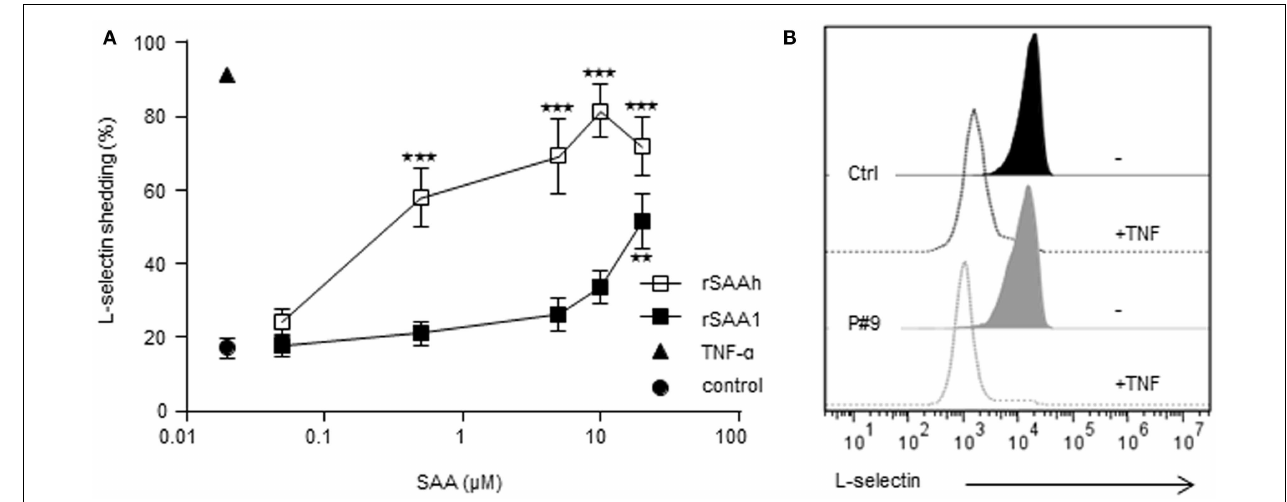
test where the SAA-treated samples were compared to the unstimulated control ( (cid:63)(cid:63) p < 0.01; (cid:63)(cid:63)(cid:63) p < 0.001). Stimulation with the positive controlTNF (10ng/ml; closed triangle) is shown for comparison. (B) Freshly drawn blood from P#9 (gray; 197 µ M SAA in plasma) and one healthy control (black) were analyzed for L-selectin expression after treatment with (closed histograms) or without (open histograms)TNF- α (10ng/ml). Histograms are representatives of numerous patients assayed independently, consistently showing resting levels of L-selectin that was efficiently shed by treatment